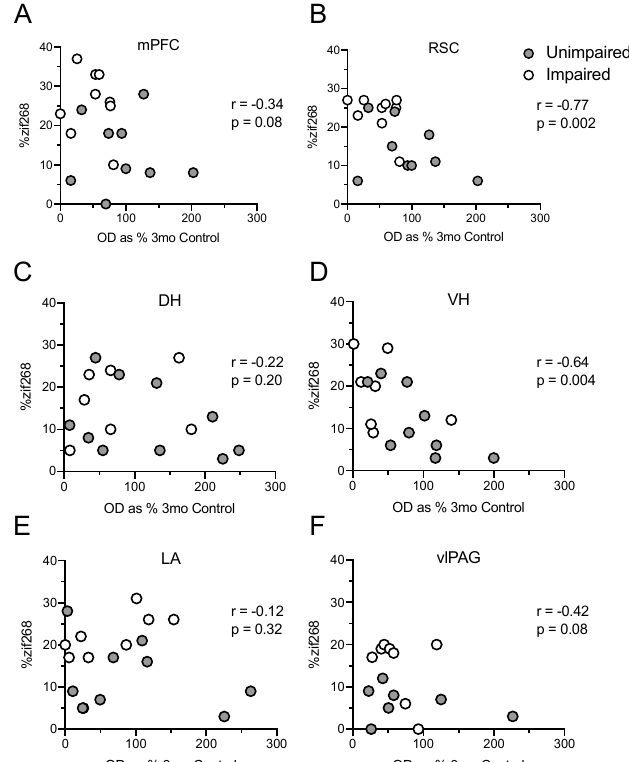
Figure 6. Scatterplots depicting correlations between phosphorylated Rpt6 and zif268 accumulation in the mPFC ( A ), RSC ( B ), DH ( C ), VH ( D ), LA ( E ), and vlPAG ( F ). Unimpaired animals are represented by gray dots, and impaired animals are represented by white dots.